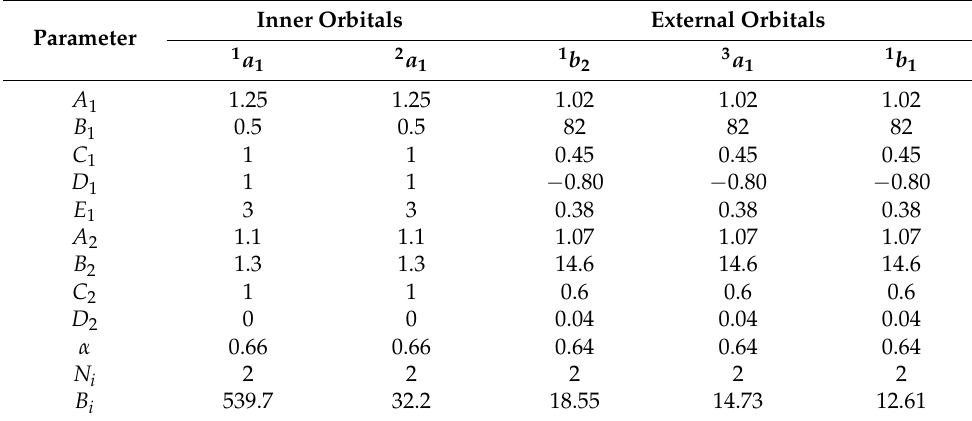
Table 1. Parameters used in this work for Equations (1)–(7). Data were extracted from [35,38].